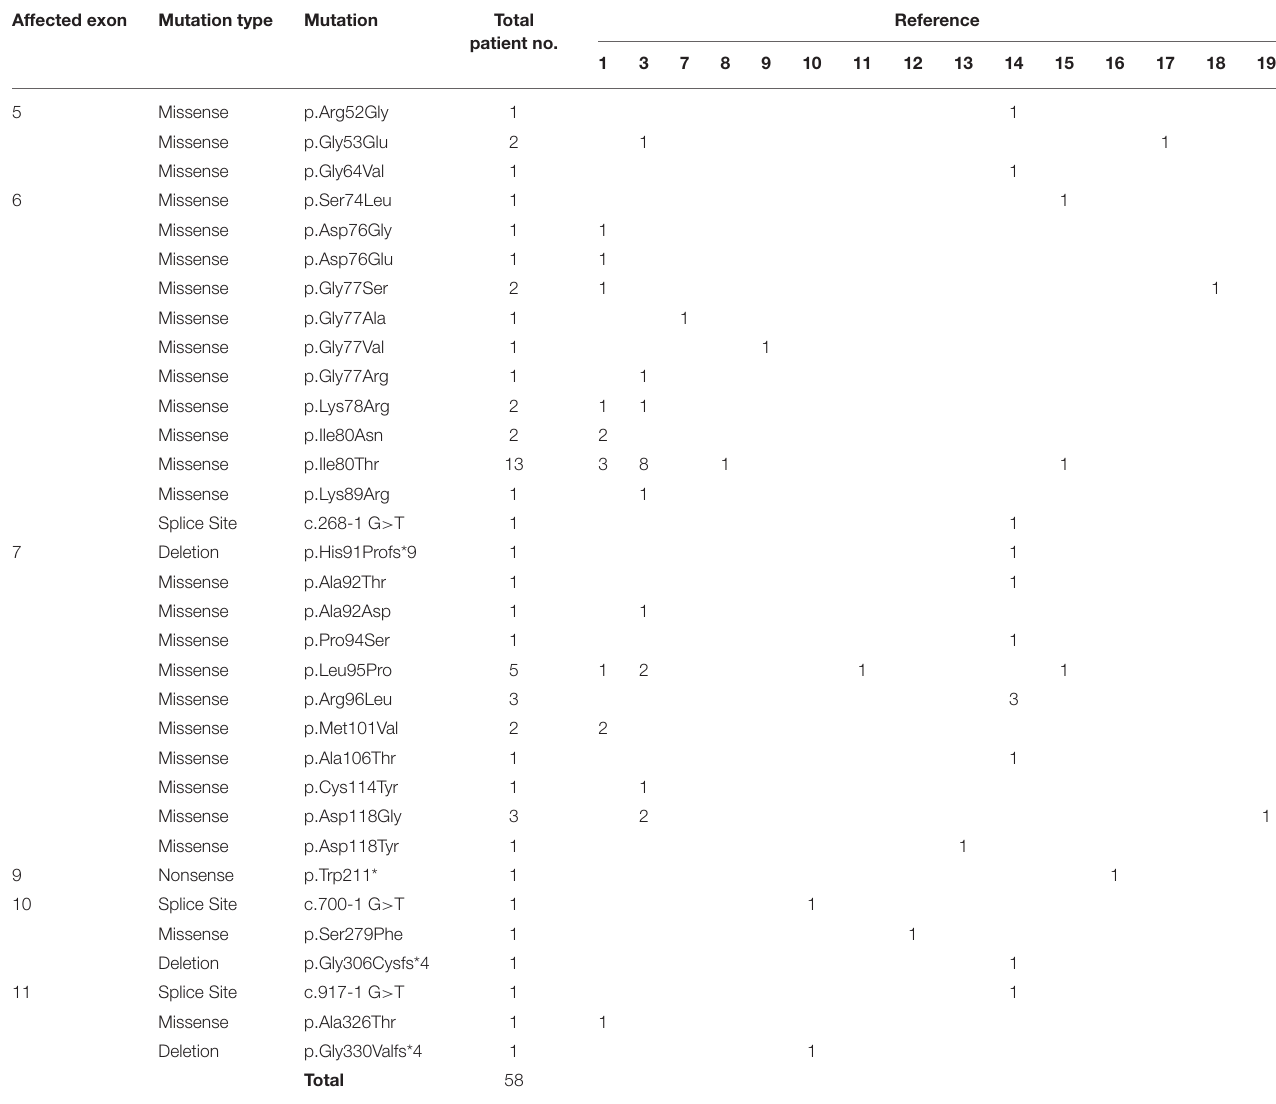
TABLE 1 | List of all patients with clinically relevant GNB1 mutations currently published. Affected exon Mutation type Mutation Total patient no.